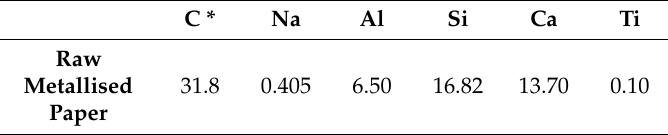
Table 1. The results showing by LAICPMS of raw metallised